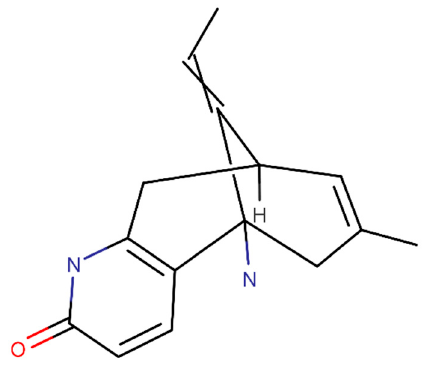
Figure 5. Chemical structure of huperzine A.